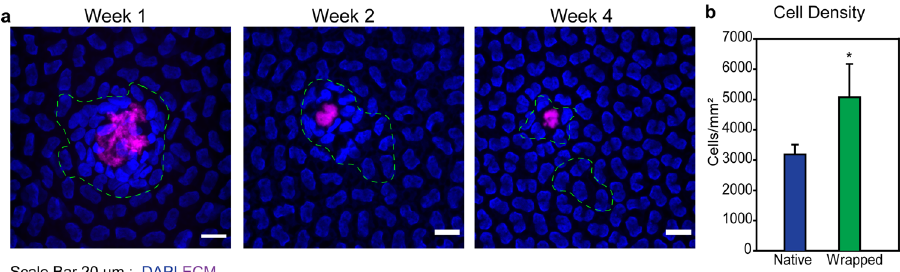
Fig. 7 Shrink-wrapped μ Monolayers exhibit stable integration into the existing healthy rabbit CE. a Confocal microscopy images showing the integrated shrink-wrapped μ Monolayers at 1, 2-, and 4 weeks post injection. The images show that the ECM scaffold is under the cell bodies post integration and that the cell density around the ECM at 1 week post injection is higher and then begins to dissipate into the outer areas by week 4 post injection. The DiO channel has been removed for clarity and a dashed green line was drawn around the cells that were DiO positive for reference. b Graph showing the cell density in the areas of the integrated shrink-wrapped μ Monolayers ( n = 18 independent green areas, represented by the green bar) compared to native areas within the same image with no DiO-labeled cells ( n = 18 independent areas with no green, represented by the blue bar). Data are represented as mean ± standard deviation and were compared using a student t test. It was found that the density in the areas with shrink-wrapped μ Monolayers was signi fi cantly higher than the native CE cell density (* p <